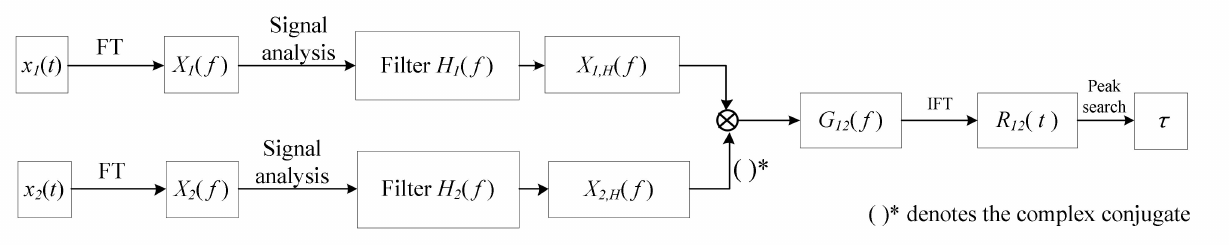
Figure 2. Flowchart of the new adaptive GCC